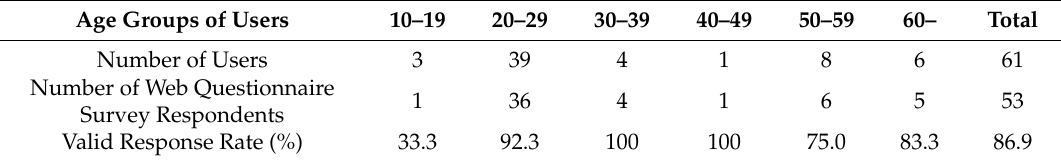
Table 1. Breakdown of system users and web questionnaire survey